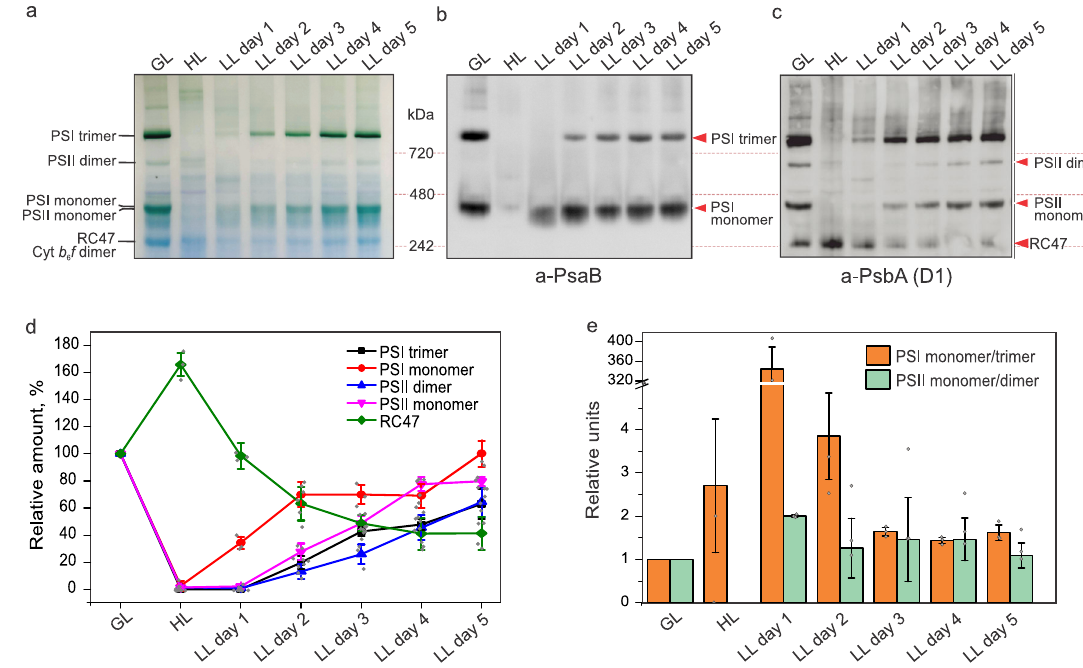
Fig. 4 Oligomerization state of PSI and PSII during thylakoid membrane biogenesis in Synechococcus . a BN-PAGE gel from isolated thylakoid membranes of cells grown under GL, HL, and HL-grown cells transferred to LL for 5 days. 200 µ g of solubilized membrane fraction was loaded per lane. RC47: PSII core complex lacking CP43. b BN-PAGE immunoblotted with antibody against PsaB. 50 µ g of solubilized membrane fraction was loaded per lane. c BN-PAGE immunoblotted with antibody against PsbA (D1). 50 µ g of solubilized membrane fraction was loaded per lane . d Relative quanti fi cation of protein amounts from BN-PAGE western blots. Values are means ± SD; n = 3 biologically independent experiments. e Relative ratios of oligomeric and monomeric state of PSI and PSII during thylakoid membrane biogenesis. Values are means ± SD; n = 3 biologically independent experiments. Gel pictures and immunoblots are representative of three biologically independent